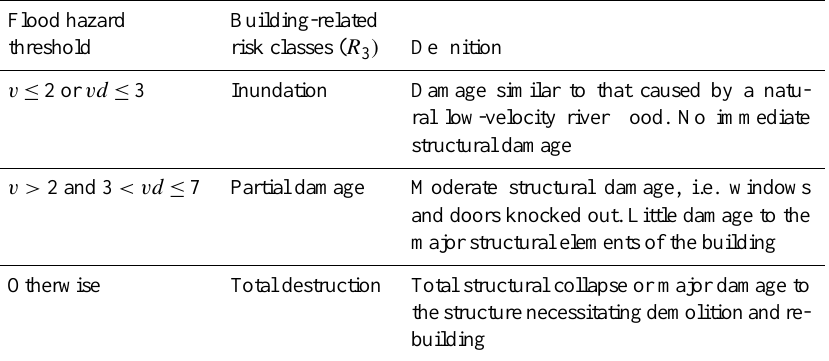
Table 1. Identification of the building-related risk classes according to specific thresholds for different values and combination of water depth ( d ) and water velocity ( v ), as proposed by Clausen and Clark (1990).